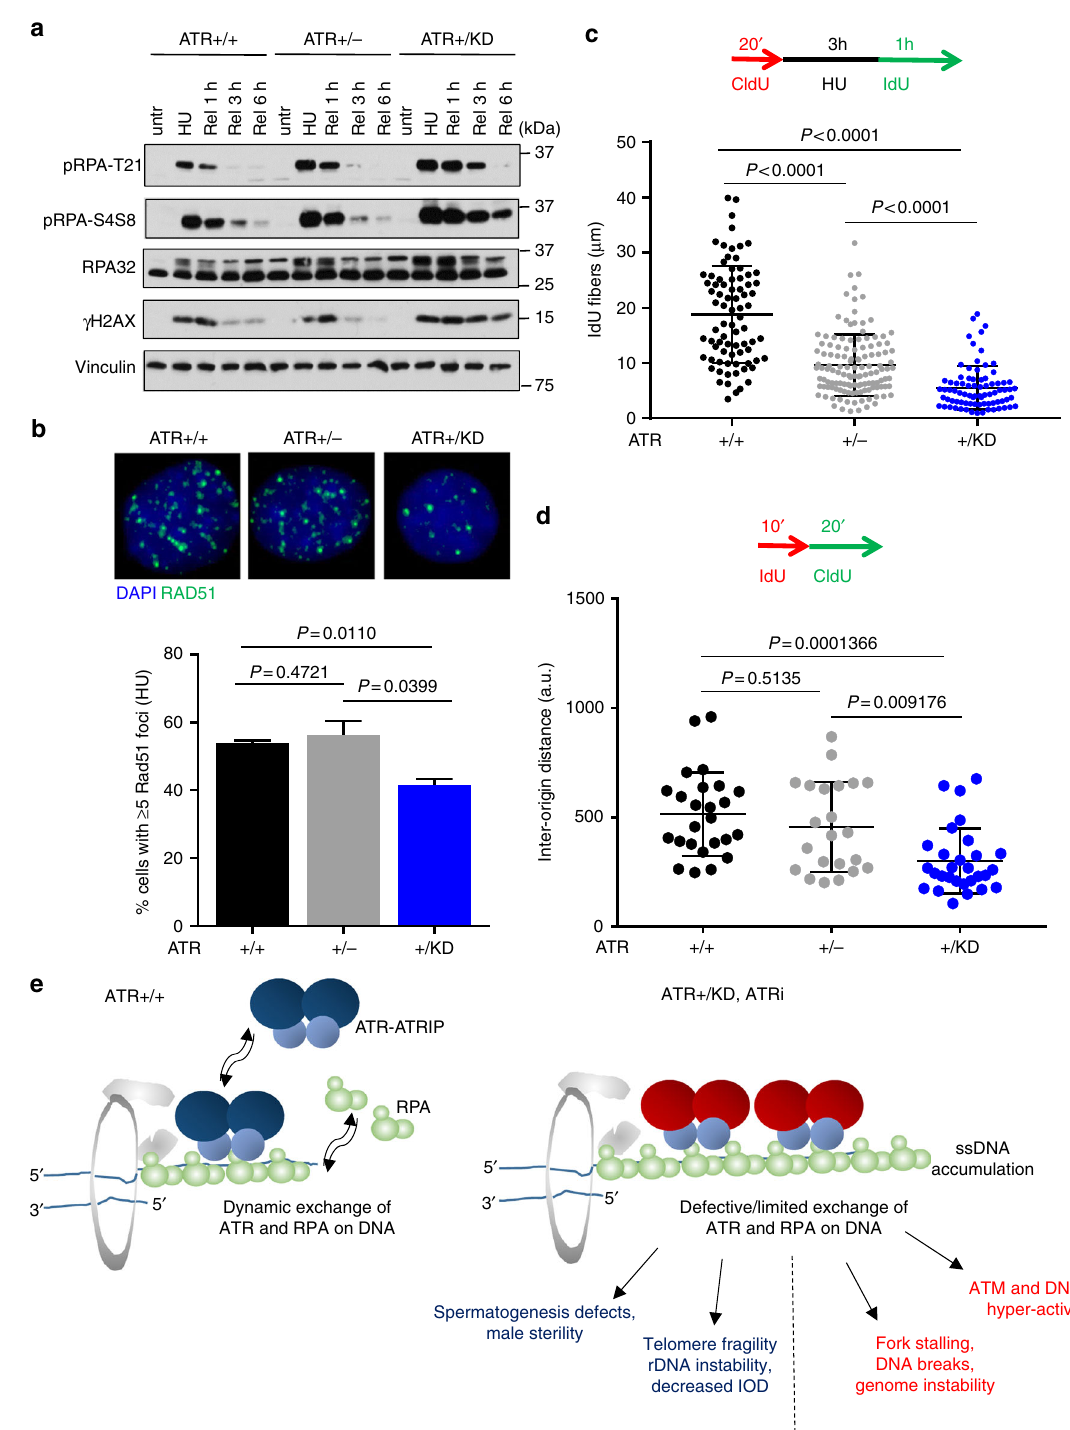
been detected in murine cells yet. Moreover, a structural study on the yeast ortholog of ATR- Mec1, suggests T1989 auto- phosphorylation site is not readily accessible by the catalytic center of ATR or its dimeric partner 29 . In this context, for the related ATM kinase and DNA-PKcs, the expression of kinase- dead protein has much more severe consequences than the loss of clusters of auto- and trans-phosphorylation sites 24 – 26,54 – 56 , sug- gesting activation associated conformation changes might occur independent of auto- or